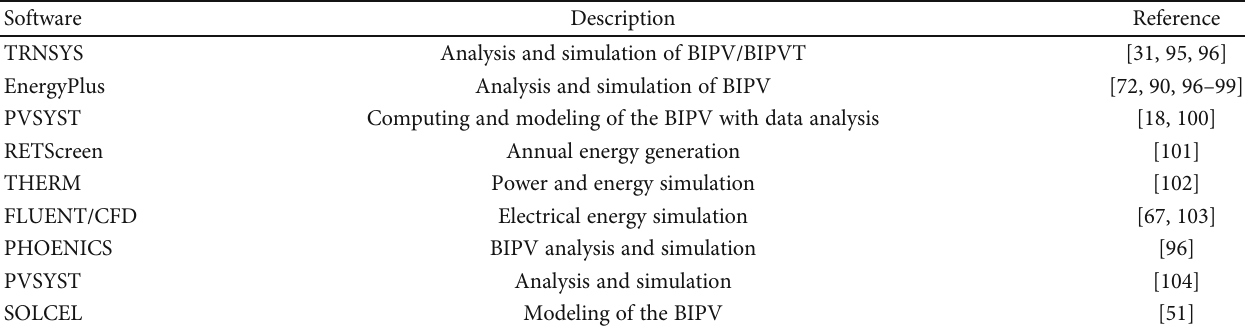
Table 6: Semitransparent BIPV analysis